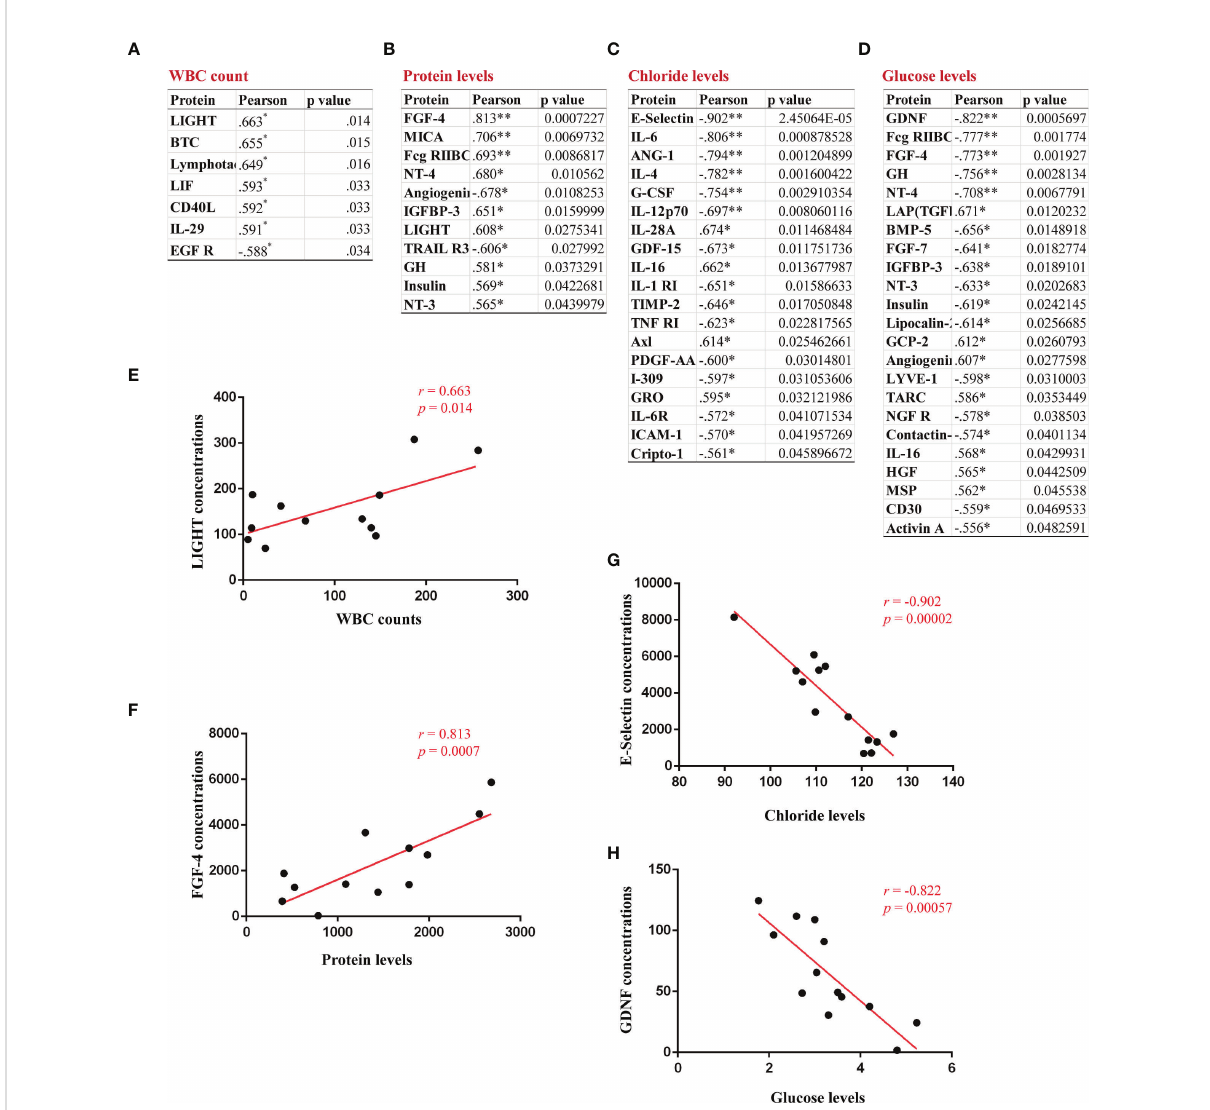
FIGURE 7 Identi fi cation of correlations between CSF abnormalities and serum proteins in GFAP-A patients. The serum proteins with a signi fi cant correlation with CSF levels of WBC count, protein, chloride and glucose are shown in (A – D). (E) A positive correlation between CSF WBC count and the serum concentrations of LIGHT. (F) A positive correlation between CSF protein levels and the serum concentrations of FGF-4. (G) A negative correlation between CSF chloride levels and the serum concentrations of E-selectin. (H) A negative correlation between CSF glucose levels and the serum concentrations of GDNF. Pearson ’ s correlation analysis was used for statistical analyses, *p<0.05, and **p<0.01 or less was considered signi fi